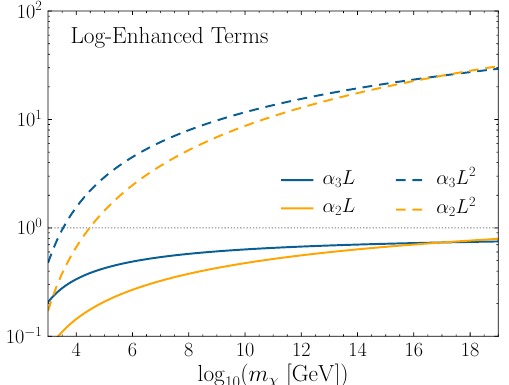
Figure 10 . Qualitative size of double and single logarithmic terms as a function of DM mass m χ . Here L = ln[ m ] , and results are shown for SU(3) and SU(2) couplings. A LL calculation χ /q W L resums the double logarithmic terms, whereas a full NLL result would resum also the single loga- rithmic terms. Clearly the αL 2 terms are rapidly larger than one, and thus must be resummed for a reliable result for most of the mass range considered in this work, and our calculation achieves this aim. The αL terms, which we do not fully resum, remain less than unity across the entire mass range. In both cases we account for the running